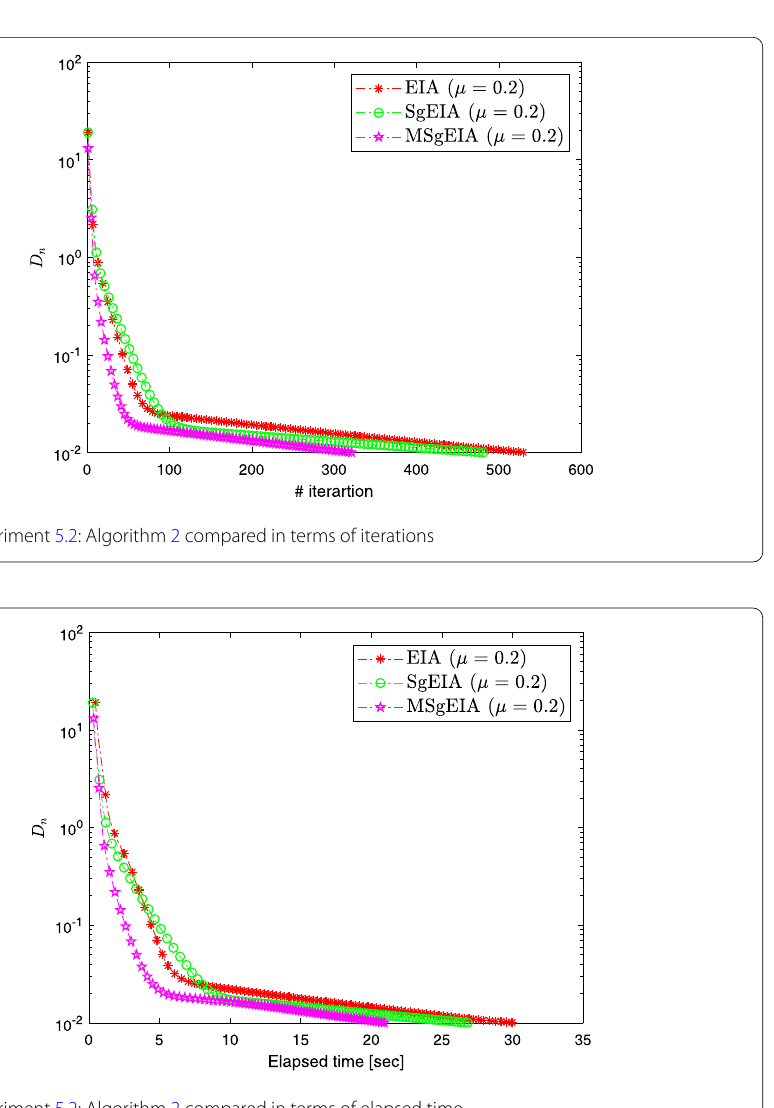
Figure 8 Experiment 5.2: Algorithm 2 compared in terms of elapsed